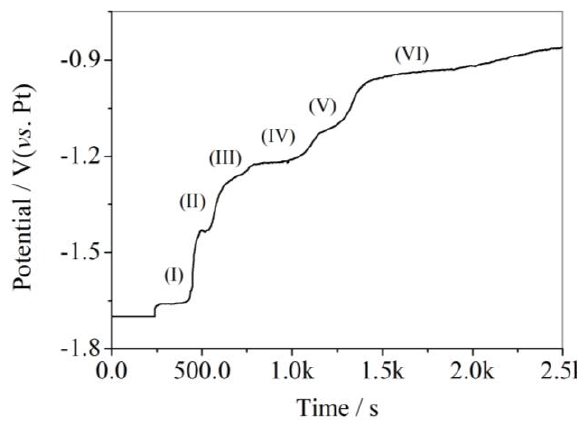
Figure 4. Open-circuit potential transient curves of a Ni sheet electrode after the application of an electrodeposition potential of − 1.70 V for 4 min in LiCl-KCl-AlCl 3 (2 wt.%) melts.